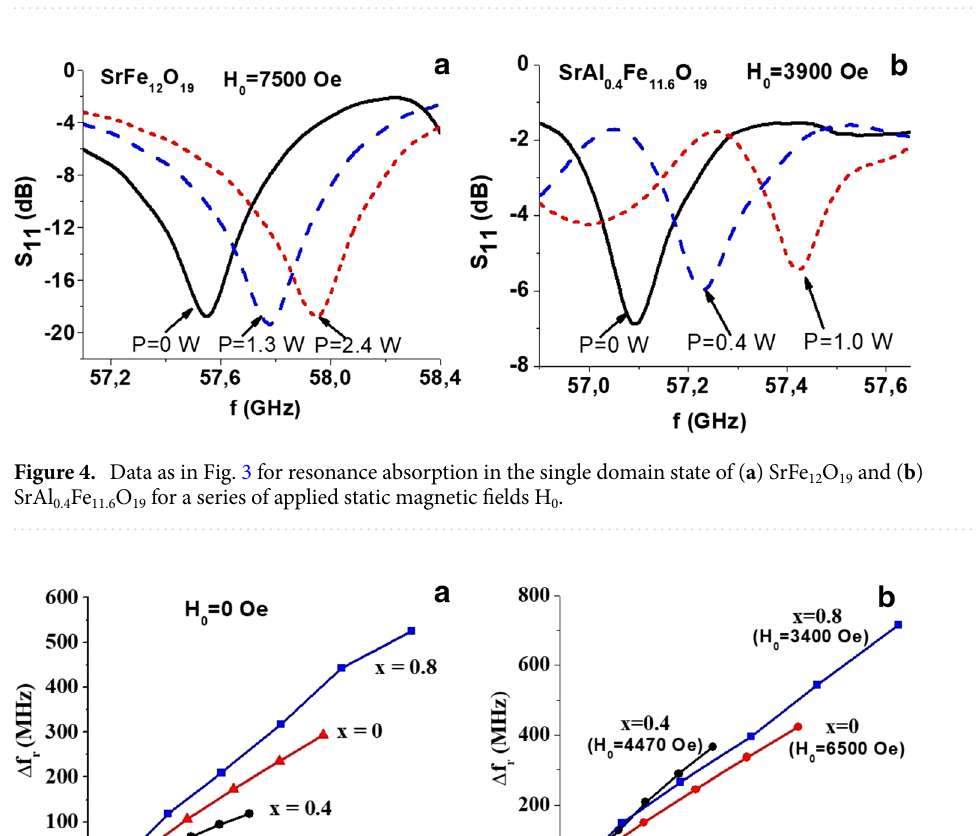
Figure 3. Return loss magnitude vs. f data for ( a ) SrFe 12 O 19 and ( b ) SrAl 0.8 Fe 11.2 O 19 in the multidomain state ( H